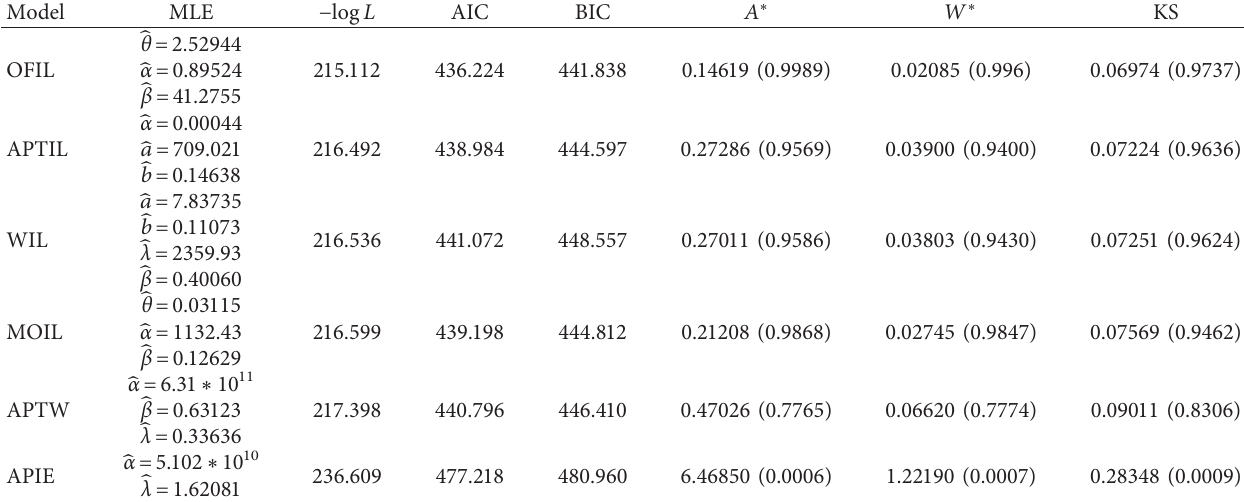
Table 11: ML estimates along with goodness of fit for data set I.